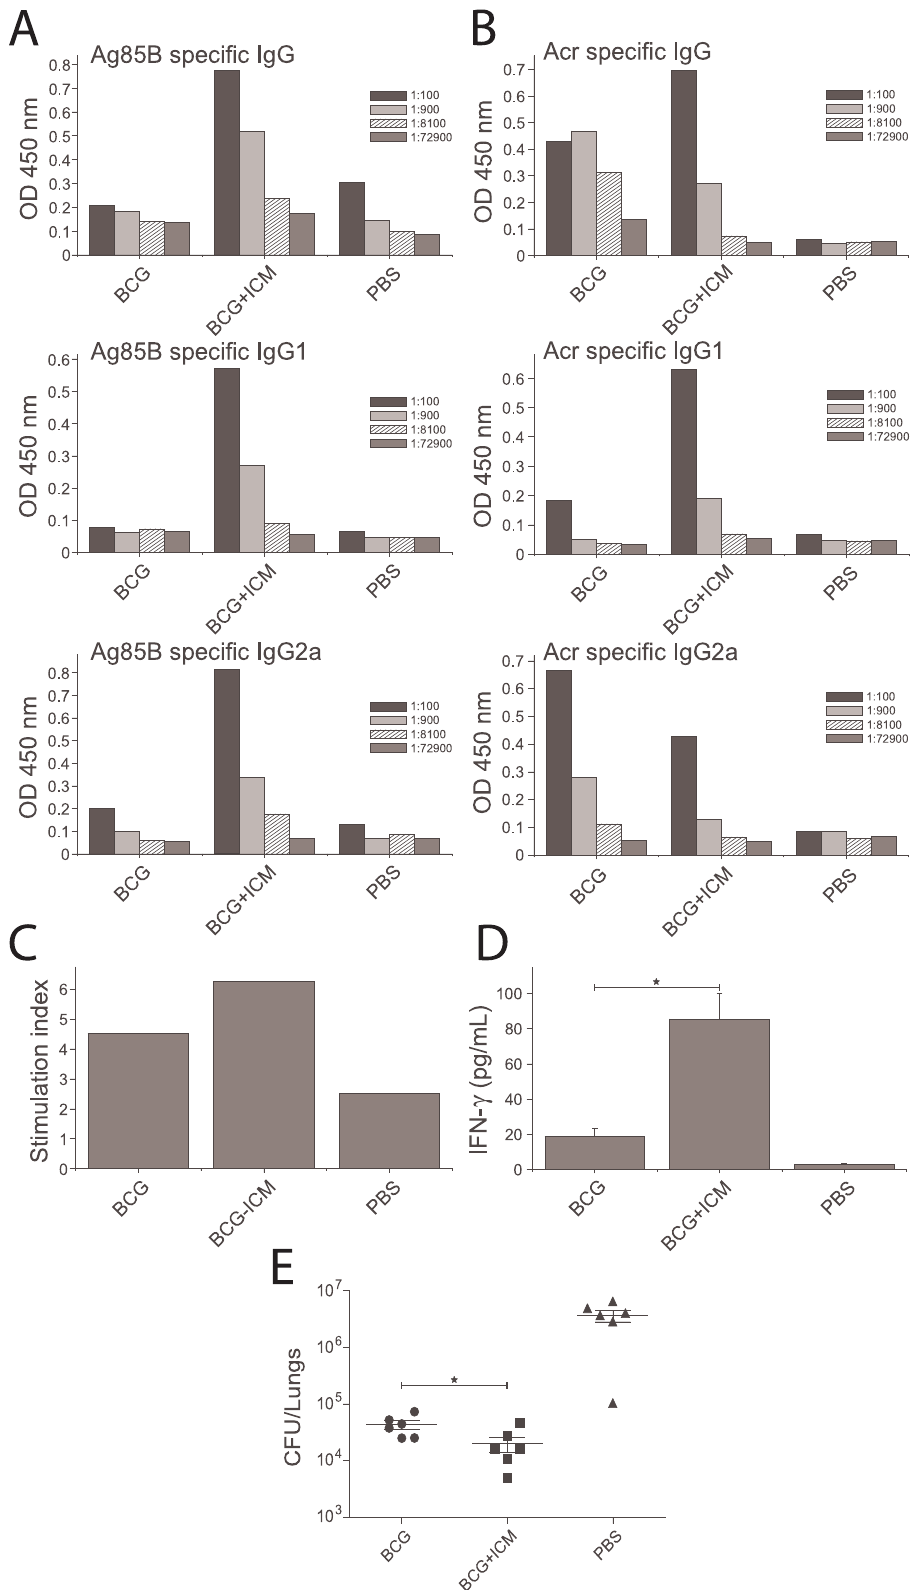
Figure 5. Immune responses and MTB bacterial counts in mice immunised with BCG and boosted with ICM. Mice were immunised s.c. with BCG and twice boosted with ICM six and eight weeks later; 2 weeks after the final boost, mice were either culled and their tissues (blood and spleens) used for immunological evaluation, or challenged i.n. with 70,000 H37Rv. * Indicates statistically significant difference (p , 0.05). A,B) Ag85B PLOS ONE |